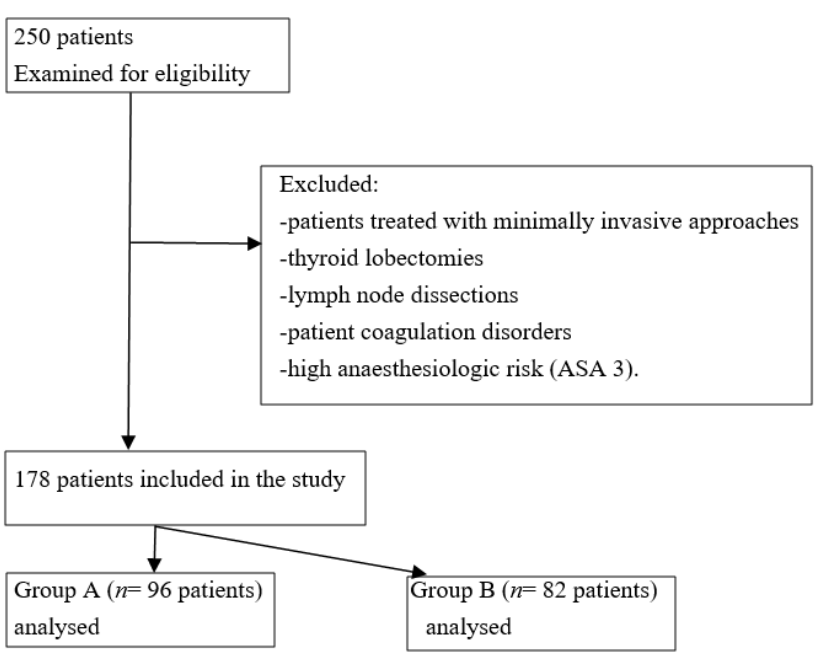
Figure 1. STROBE Figure 1. STROBE flowchart.